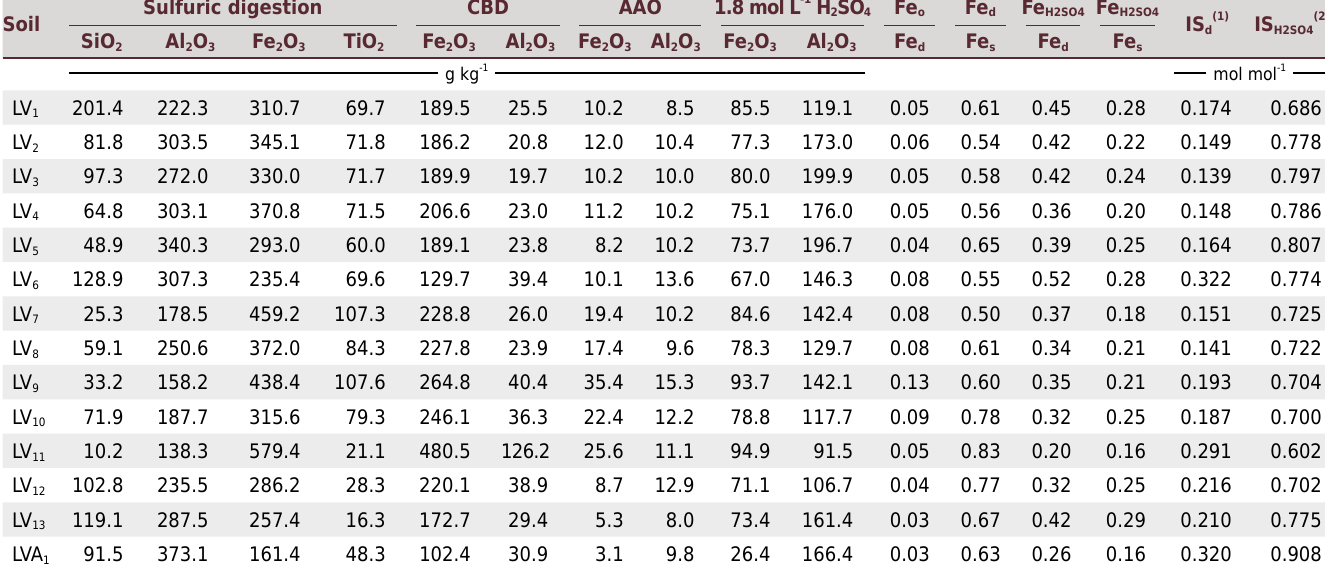
Table 2. Silicon, Al, Fe, and Ti contents determined by sulfuric digestion of ADFE (Si s , Al s , Fe s , and Ti s ) and Fe and Al obtained in the clay fraction by sequential extractions with citrate-bicarbonate-dithionite (CBD) (Fe d and Al d ), only one extraction with acid oxalate ammonium (AAO) (Fe o and Al o ) and 1.8 mol L -1 H 2 SO 4 (Fe H2SO4 and Al H2SO4 ) all presented as oxides Sulfuric digestion Soil